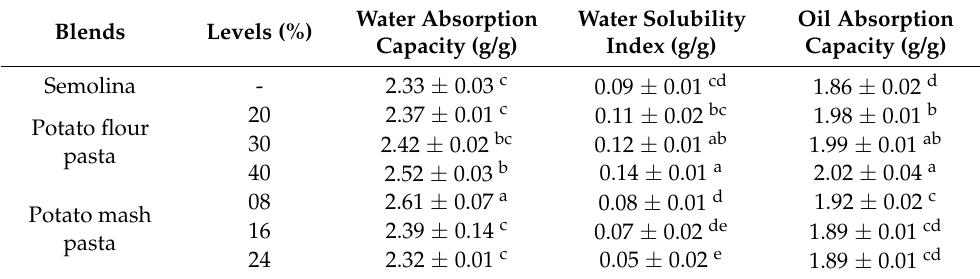
Table 2. Effect of replacing potato powder and mash with semolina on the functional properties of pasta